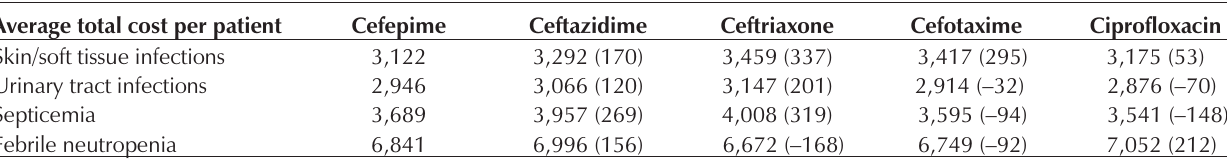
Average cost (in 1994 CDN $) per patient for four infectious diseases*